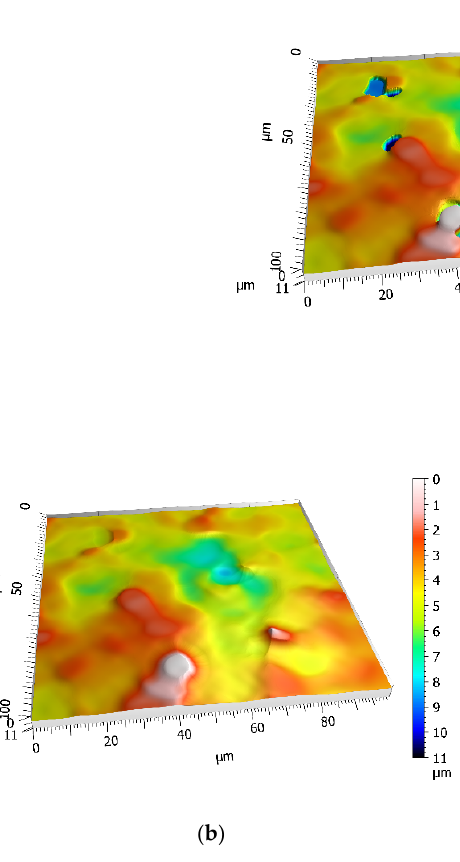
Figure 3. Morphological surface filtration: ( a ) raw surface; ( b ) after filtration using 16 µ m sphere, closing filter; ( c ) residue surface, all outliers clearly visible.